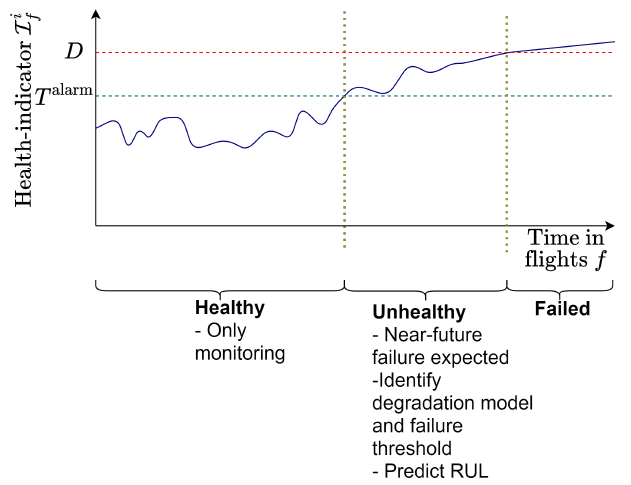
Figure 1. A component i is defined as healthy or unhealthy, based on a degradation indicator I i which is updated every flight f . Once a component is unhealthy, a degradation model is identified, and the RUL is